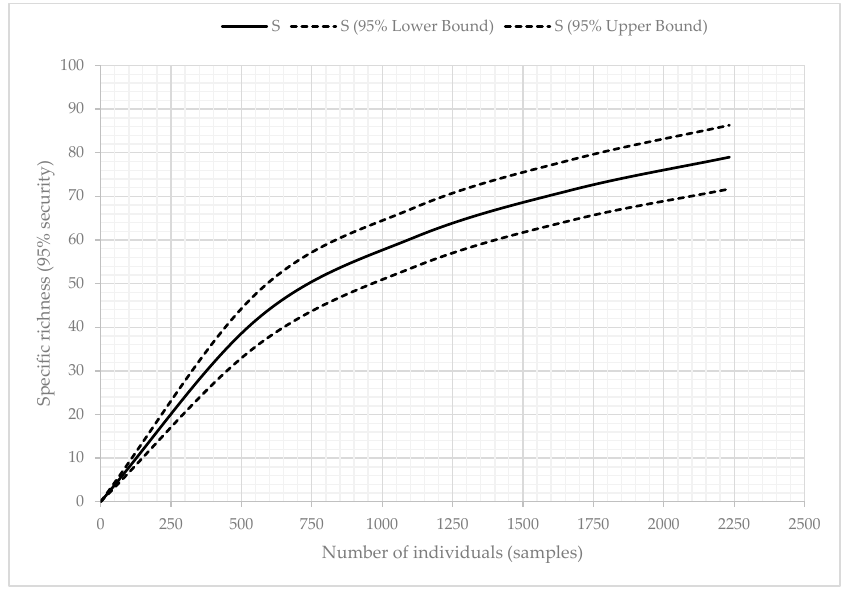
Figure 4. Species rarefaction curve of fishes sampled in the MpDNP rivers.